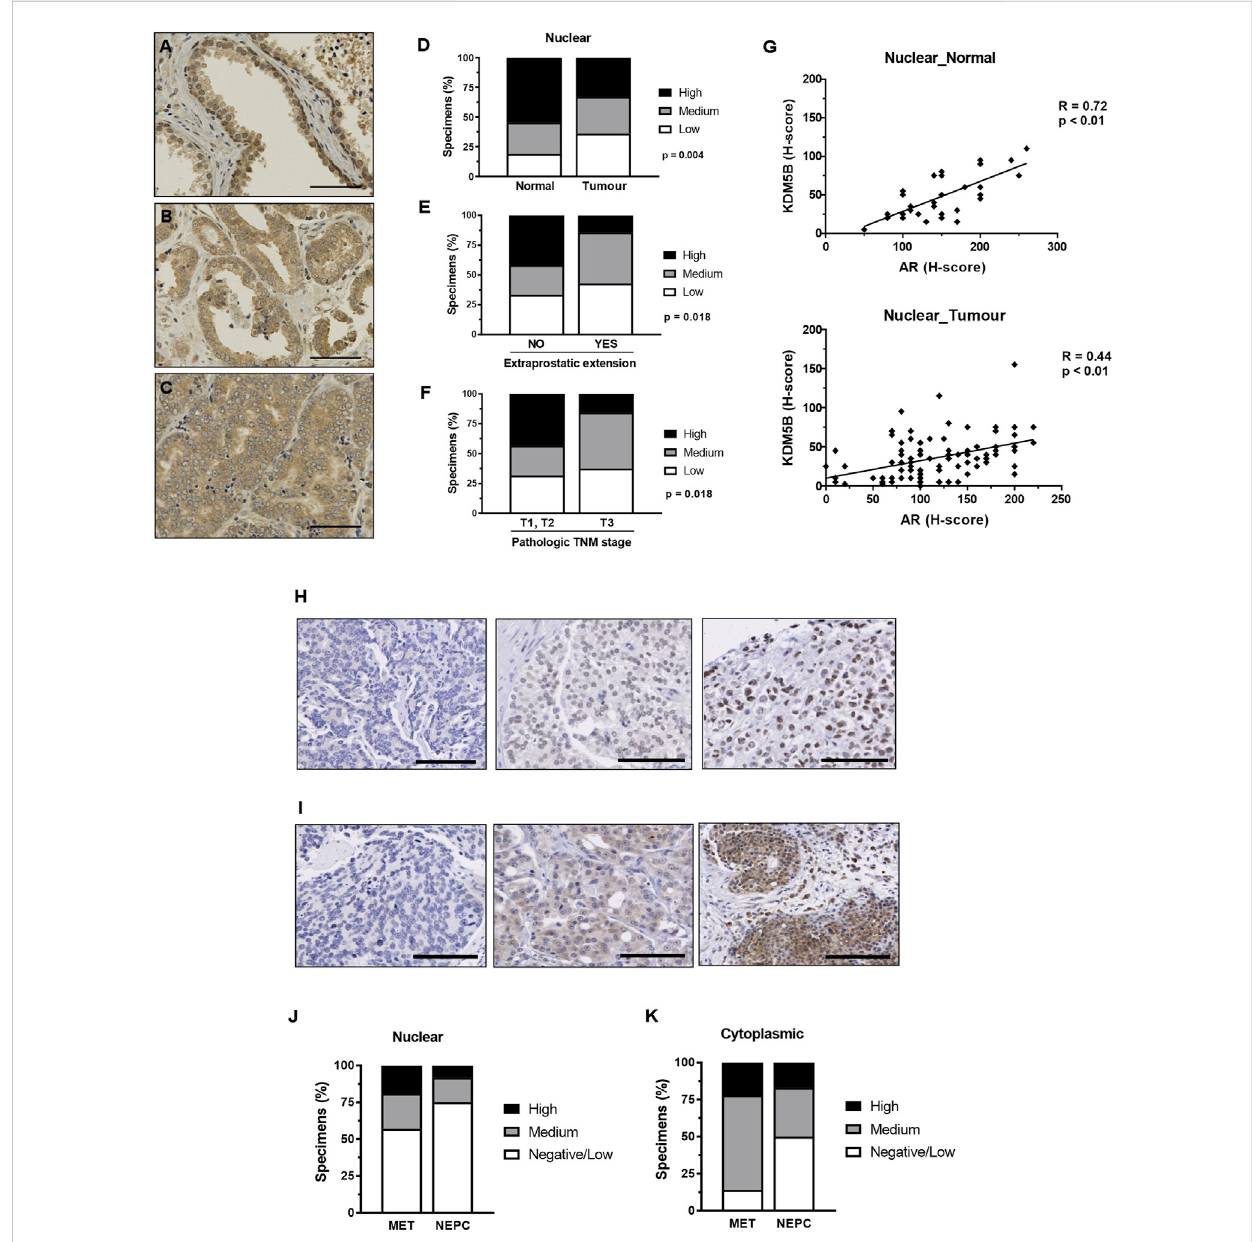
FIGURE 2 KDM5B in PCa specimens. Immunohistochemistry analysis of KDM5B protein in non-malignant, benign, primary and metastatic adenocarcinomas plus neuroendocrine prostate tumors. Cohort 1_non-malignant/normal ( n = 43) and prostate adenocarcinomas ( n = 97) specimens. Representative KDM5Bstainingofnon-malignanttissue (A) ,adenocarcinoma (B) andlessdifferentiatedtumourtissue (C) nuclearstaining,scalebar=50 µM. (D) Nuclear H-scores were split into 3 groups, low (0 – 20), medium (25 – 40) and high (45 – 155), % number of specimens/group are shown. SPSS analysis was performedusingclinicaldatatocorrelate clinicalparameterswithKDM5Bintensitiesinthetumours( n =97).Signi fi cantdifferencesinthelevelofKDM5B was identi fi ed with (E) extraprostatic extension and (F) TMN staging. Statistical p -values were determined by χ 2-test. TNM = tumour, node, metastasis, scalebar=100 µM. (G) KDM5BnuclearH-scorecorrelationwithARnuclearH-scoreinnon-malignant normaltissue( n =33)andtumourspecimens( n = 95). Pearson ’ s correlation with p -values is shown. Cohort 2 consisted metastatic ( n = 40) and NEPC ( n = 13). Representation of low to high (Left to right) levelsofnuclear (H) andcytoplasmic (I) stainingisshown. Nuclear (J) andcytoplasmic (K) H-scores weresplitinto3groups,Negative/low( < 50),medium (50 – 100) and high ( >